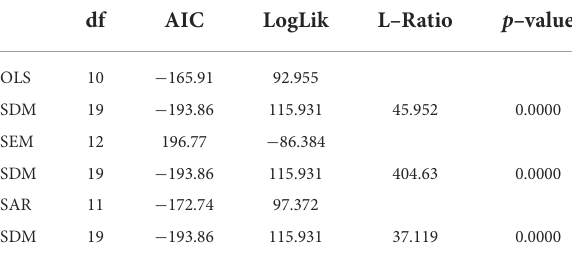
TABLE 4 Figures on the